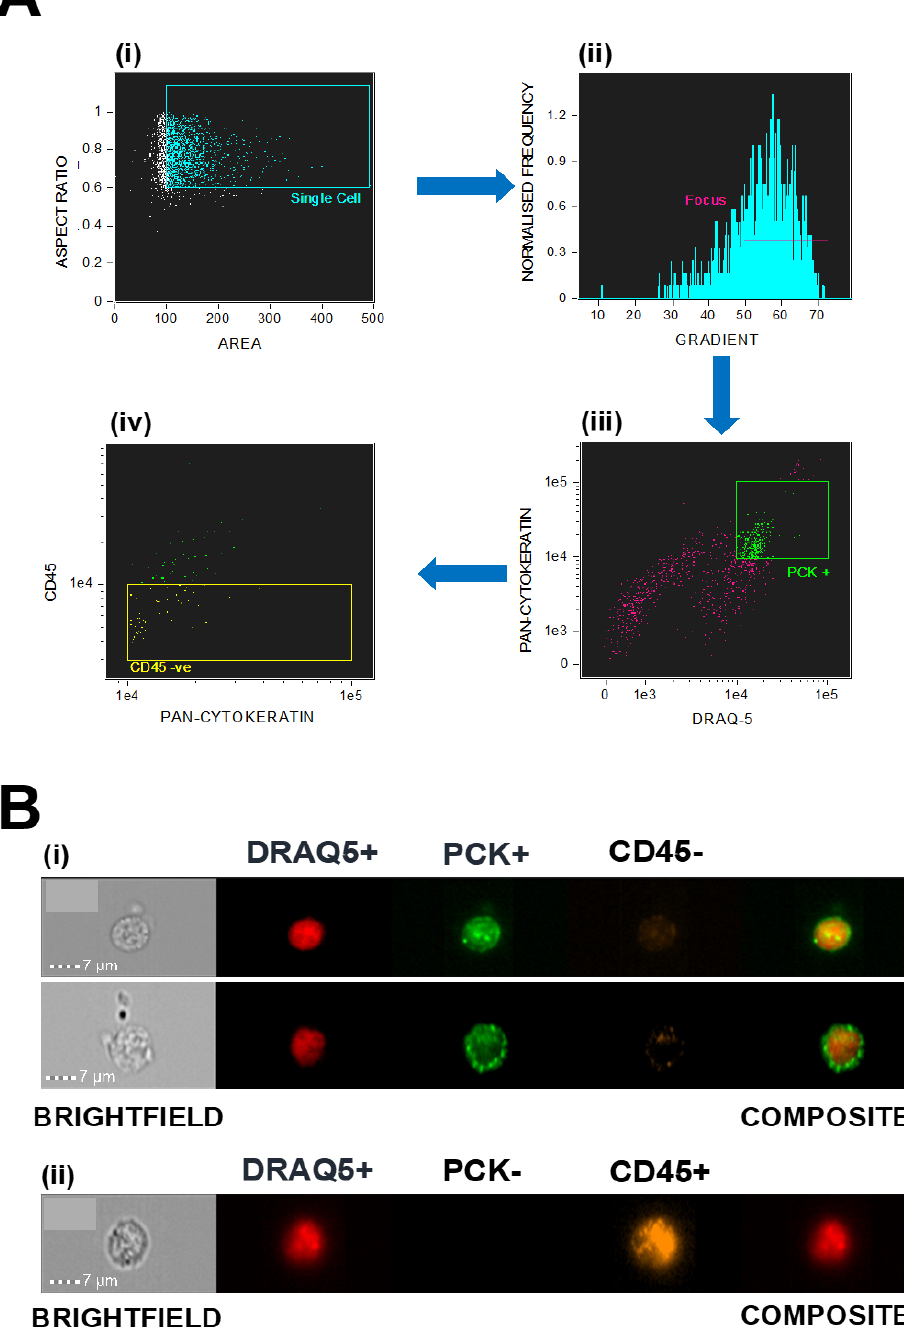
Figure 1. ( A ) Graphs illustrating the criteria used to filter the images taken from ImageStream ® X Mk II for analysis in IDEAS. Each image is displayed by a single dot and the selection criteria appears either as a box (i, iii, iv) or a line (ii); (i) shows the images filtered via size and circularity; (ii) represents the single cells filtered by focus of the images; (iii) shows the in-focus cells that are double-positive stained for PCK and DRAQ5; and (iv) represents the double-positively stained cells that are negative for CD45 staining. ( B ) Images showing (i) two PCK +/ CD45 − CCs and (ii) an example of a PCK − / CD45 + leucocyte. All images are stained positive with DRAQ5 nuclear staining.